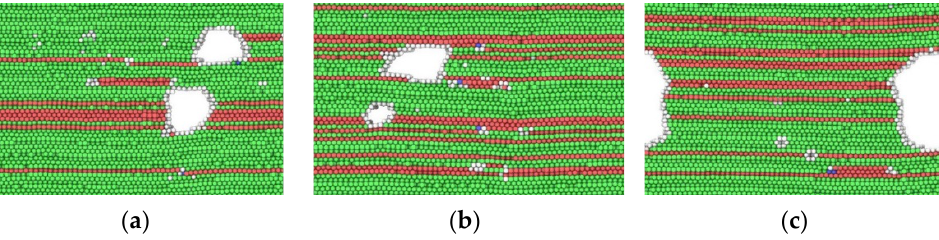
Figure 4. Residual pores in the welding interface zone of Model I after five cycles of sinusoidal sliding under the clamping pressure of 135 ( a ), 270 ( b ), and 540 MPa ( c ). Atoms are colored according to their local crystalline structure (see description in text). The cutouts are made only in the vertical direction, the whole width of a computational cell is displayed in each case.